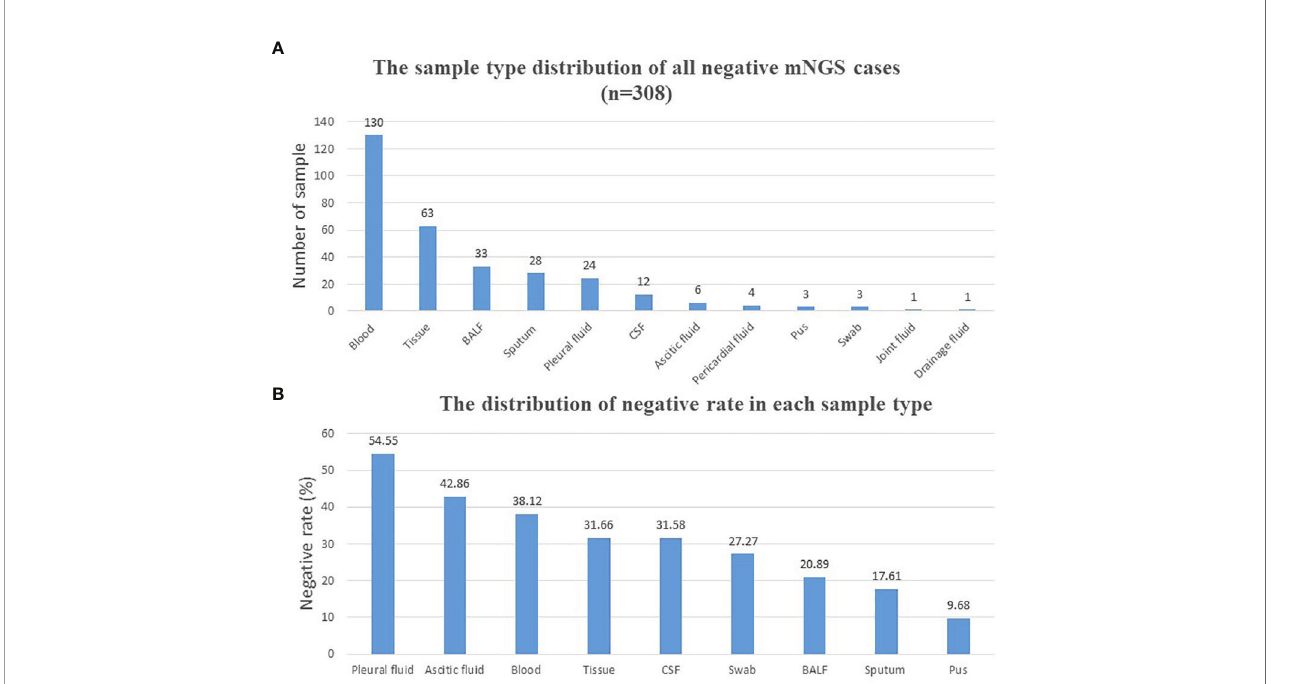
FIGURE 1 | Distribution of negative mNGS cases. (A) Distribution of all mNGS negative cases according to different sample types. (B) Negative rate calculation and distribution of each sample type. BALF, bronchoalveolar lavage fl uid; CSF, cerebrospinal fl uid; mNGS, metagenomics next-generation